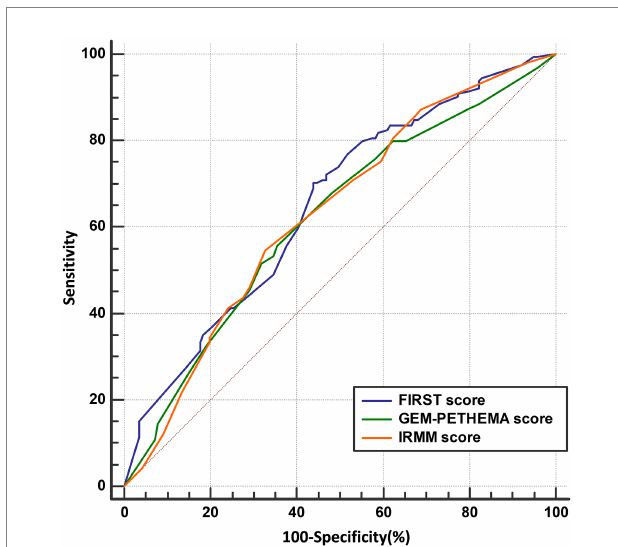
FIGURE 4 ROC curve analysis results of three models. ROC curve of FIRST score (AUC = 0.650), GEM-PETHEMA score (AUC = 0.619), and IRMM score (AUC = 0.630).